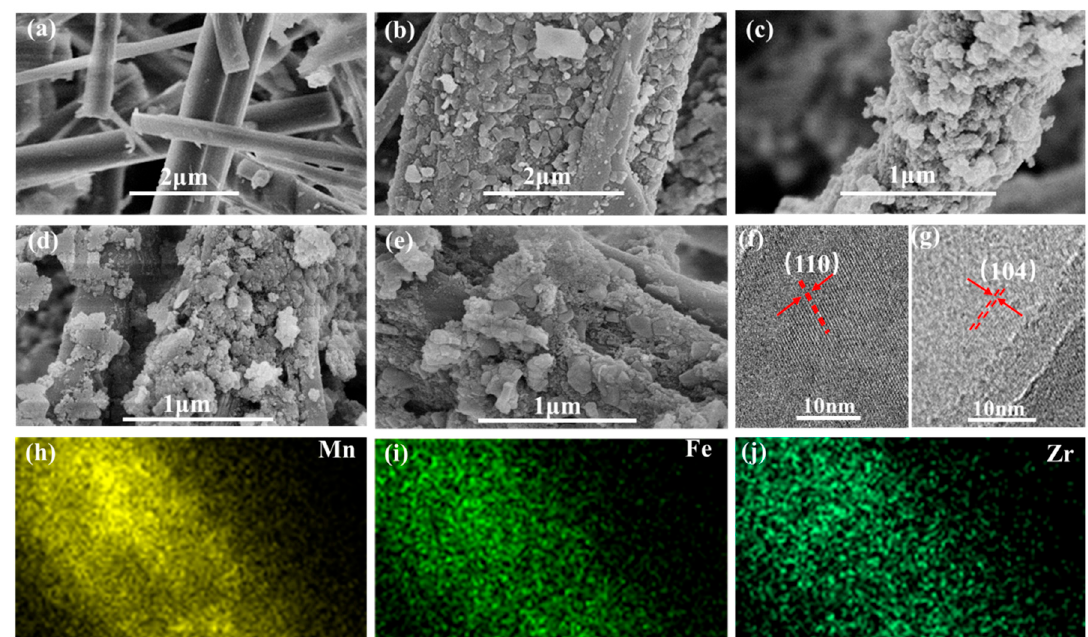
Figure 5. SEM and TEM of ZrMnFe/SEP: ( a ) SEM of SEP, ( b ) SEM of Fe/SEP, ( c ) SEM of Mn/SEP, ( d ) SEM of MnFe/SEP, ( e ) SEM of ZrMnFe/SEP, ( f,g ) Fe (110) planes and Fe (104) planes in TEM of ZrMnFe/SEP, ( h – j ) mapping images of ZrMnFe/SEP.